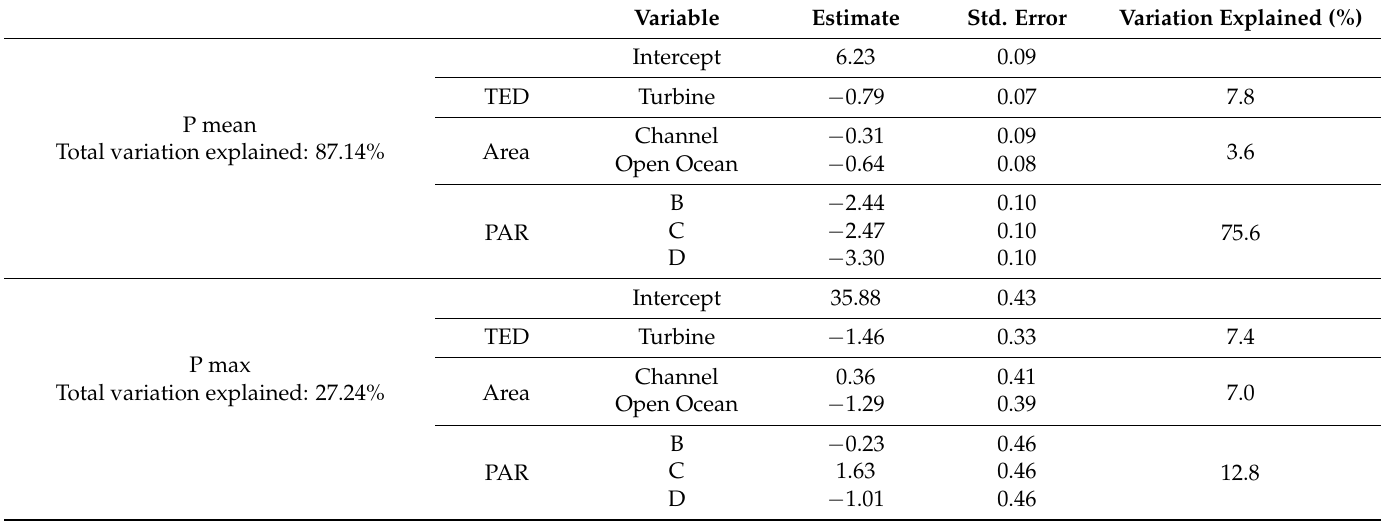
Table 4. Results of general linear models for mean, max, and cumulative values of phytoplankton and maximal and cumulative values of nitrogen. The variables turbine, location, and radiation year are categorical variables, with the following categories: Turbine: no turbine/turbine; Location: basin/channel/open ocean; and Solar Radiation: A/B/C/D. Residual standard error, multiple R-squared, F, and p -value are not displayed as they are not meaningful in this context